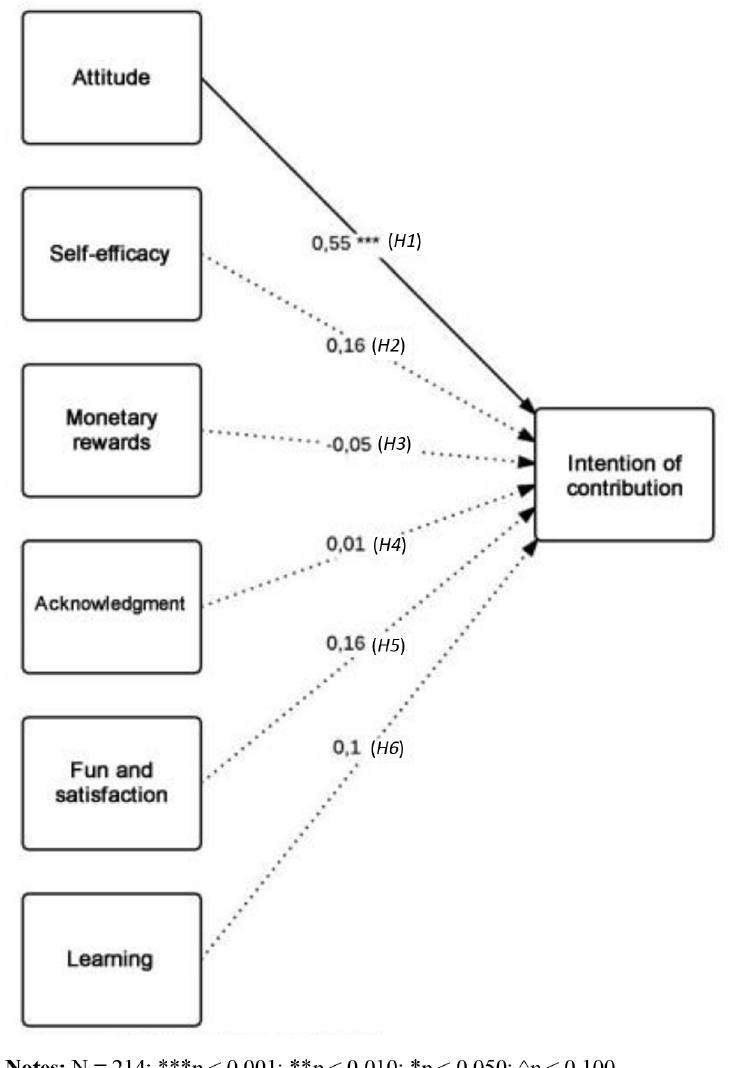
Figure 2. Calculated